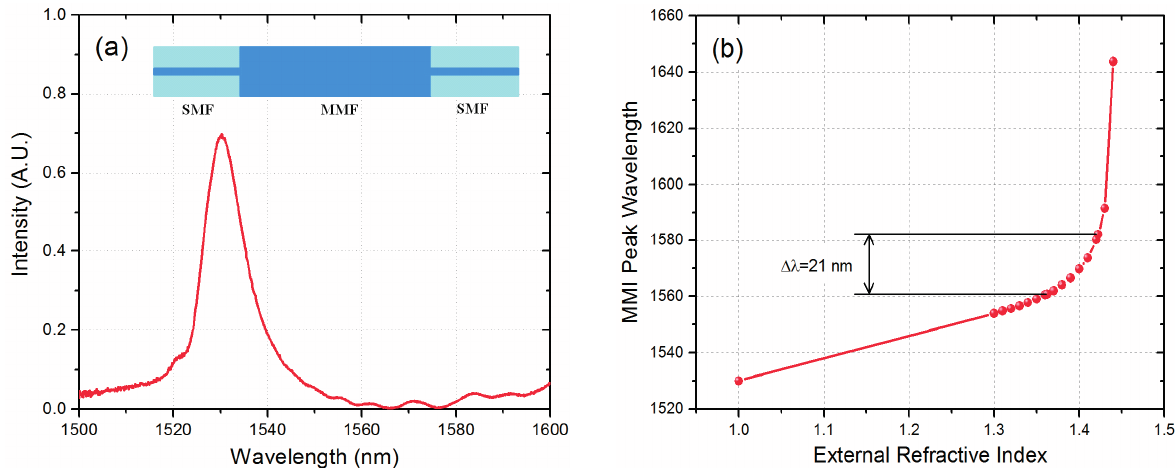
Figure 1. ( a ) Spectral response of an MMI device (Inset: schematic of a MMI device) and ( b ) MMI peak wavelength response as a function of the RI of the external